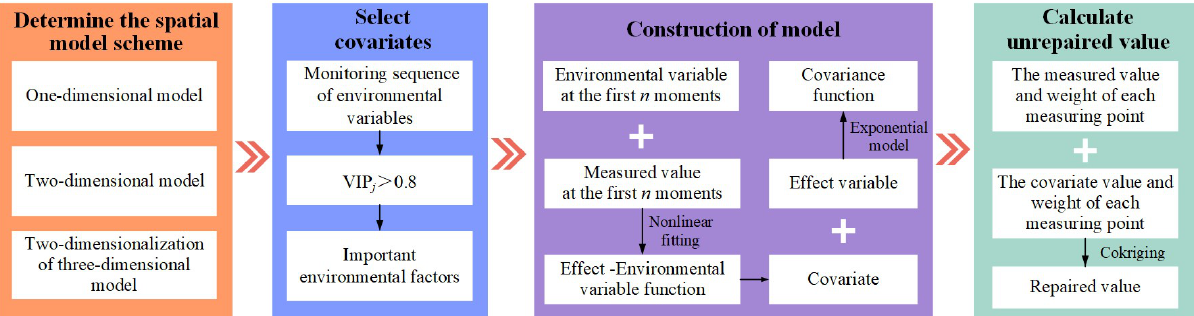
Figure 1. VIP–cokriging spatial model construction flow chart. Figure 1. VIP-cokriging spatial model construction flow